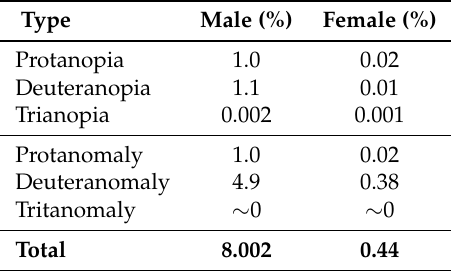
Table 2. Approximate percentage occurrences of various types of color vision deficiency